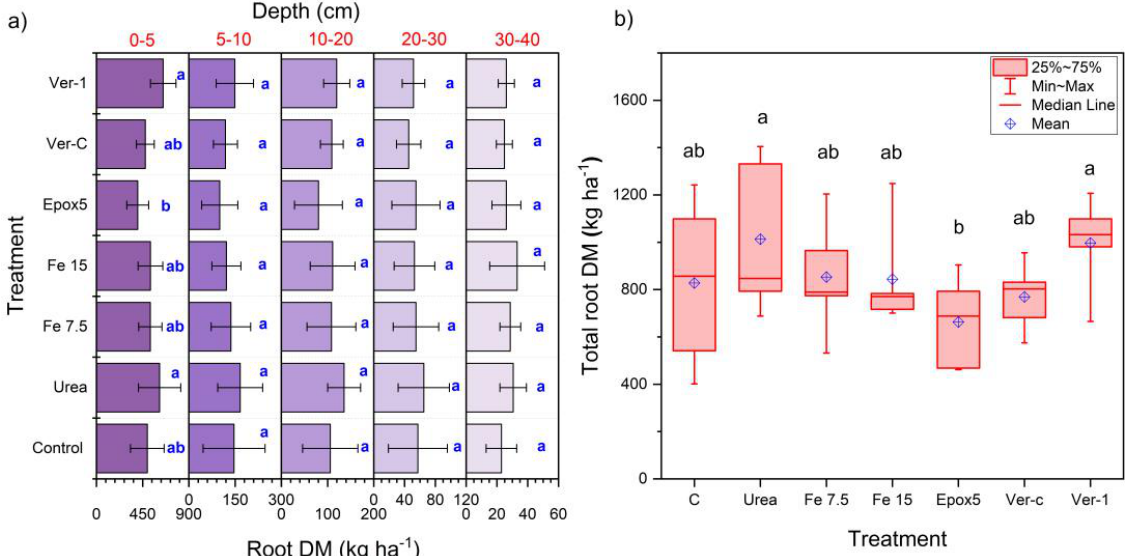
Figure 6. ( a ) Depth-wise root DM distribution; error bars show the standard deviation ( n = 5) and ( b ) total root DM (TRDM) for different treatments. Different letters indicate the significant differences between the treatment within a depth in ( a ), and the total root DM in ( b ), at p < 0.05 ( n = 5).